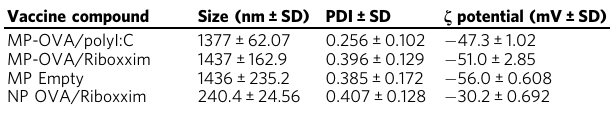
Table 1 Particle size, polydispersity index (PDI), and ζ - potential of PLGA micro- and